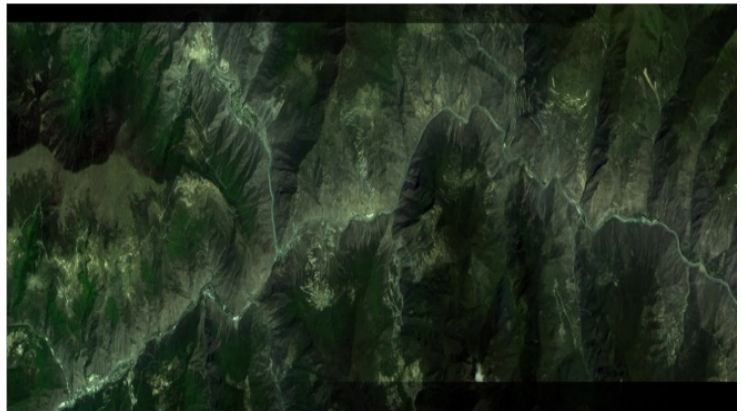
Figure 8. The stitched GF-1 image.